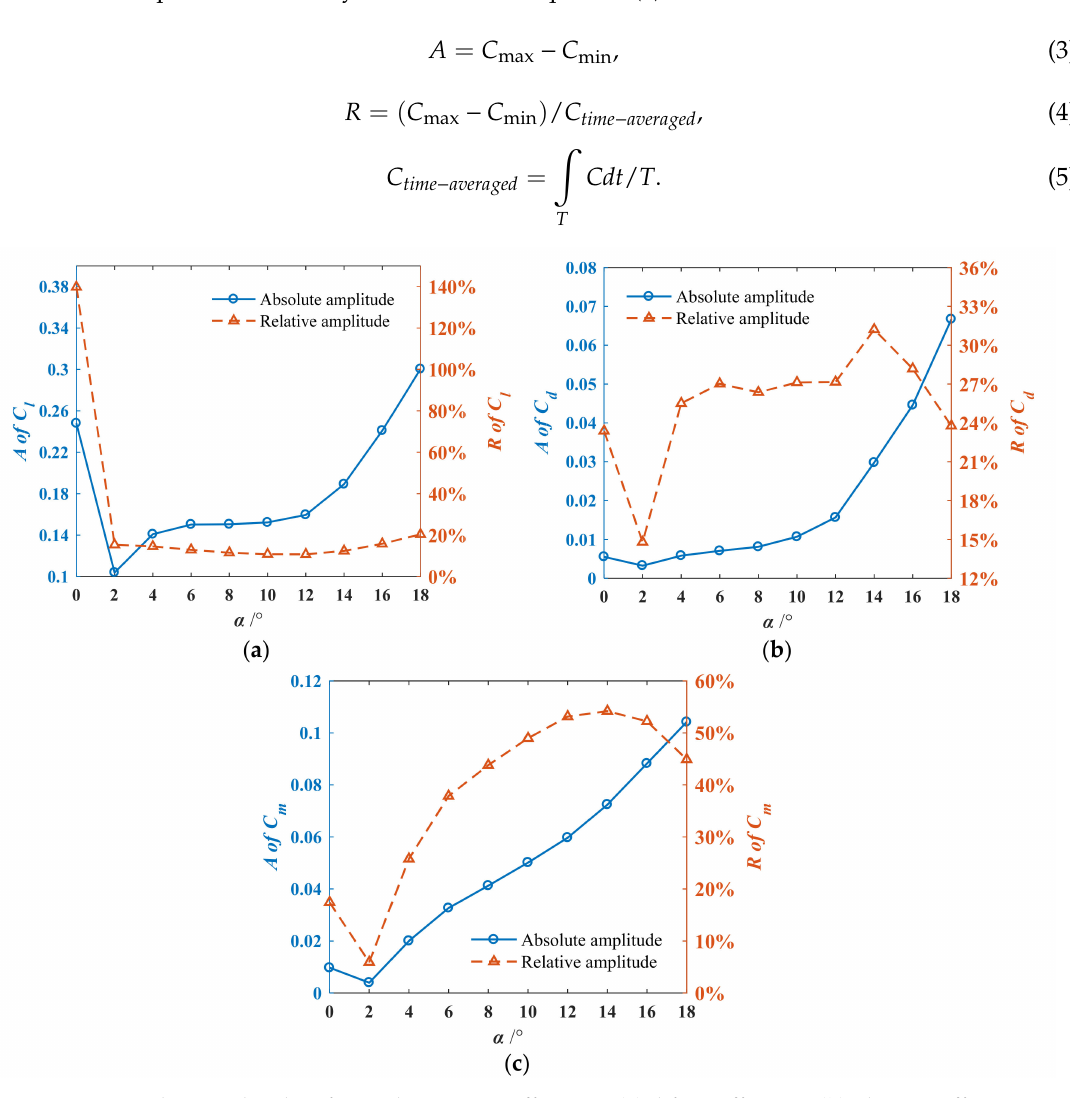
Figure 7. The amplitude of aerodynamic coe ffi cient: ( a ) lift coe ffi cient, ( b ) drag coe ffi cient, ( c ) moment coe ffi